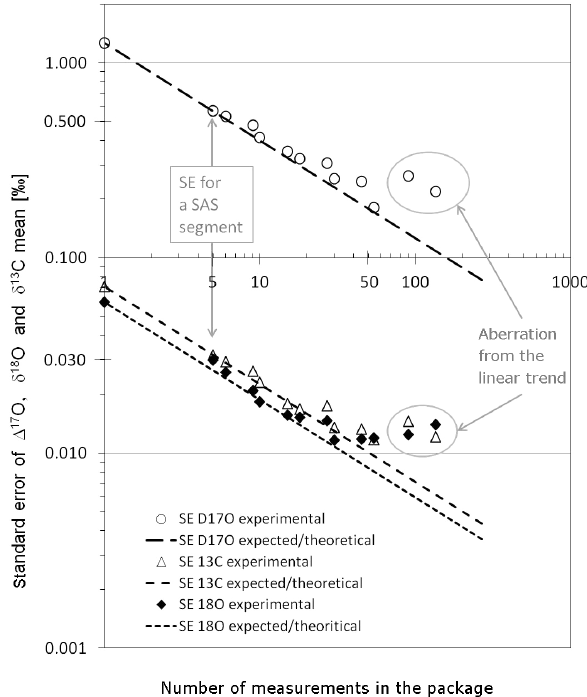
Figure 8. Correlation of ln(SE) vs. ln( n ) for (cid:49) 17 O(CO 2 ) (based on data from Table 1), δ 18 O(CO 2 ) and δ 13 C(CO 2 ). SE is the stan- dard error of the mean, and n is the number of measurements in a package. The experimental SE of (cid:49) 17 O, δ 18 O and δ 13 C are shown as circles, triangles and black diamonds respectively. The dashed/dotted lines are the theoretically expected slopes for the linear correlation between ln(SE) and ln( n ). For a packages of n ≤ 54, the experimentally derived slopes are − 0.46 ± 0.02 for (cid:49) 17 O, − 0.42 ± 0.03 for δ 18 O and − 0.45 ± 0.03 for δ 13 C. The val- ues are close to the theoretical slope of − 0.50 (dotted/dashed lines). Based on this experiment we expect an uncertainty of ± 0.57‰ for (cid:49) 17 O of an AirCore air sample stored in an individual SAS seg-